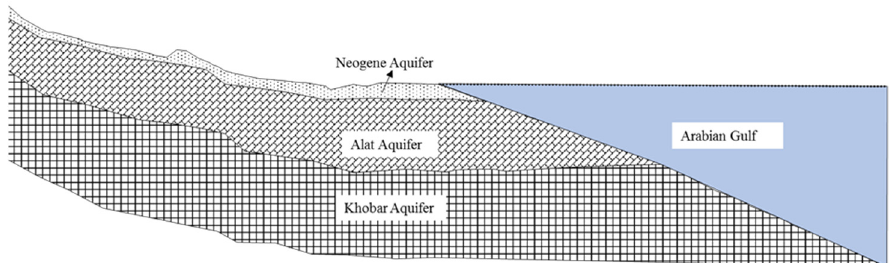
Figure 5. General hydrogeological section of the aquifer system in the study area [30].